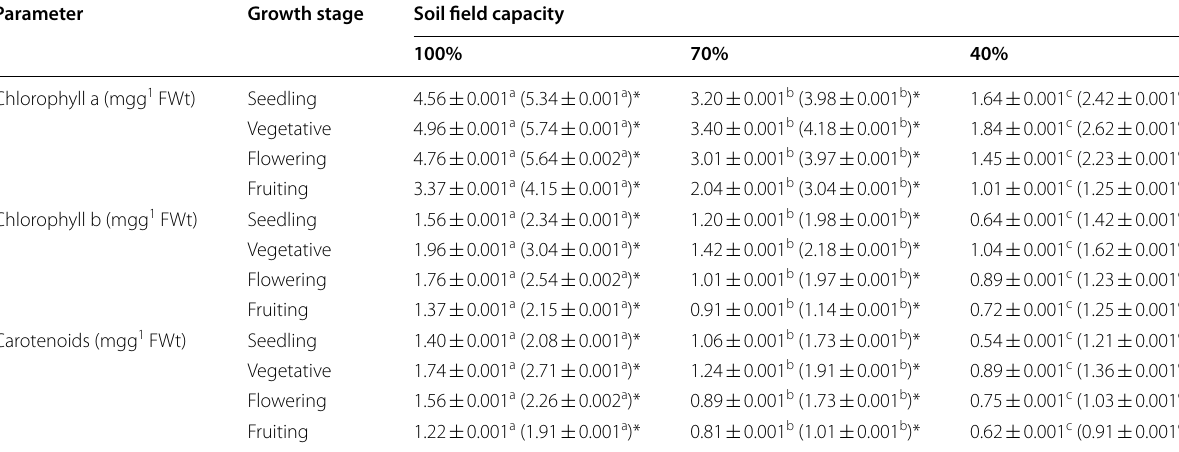
Values of parameters in parentheses correspond to the application of mycorrhiza. Values in a row with different superscript letters are significantly different at P < 0.05 * Significant effect of mycorrhiza application at each soil field capacity at P < 0.05 according to t ‑test ns : non‑significant effect of mycorrhiza application at each soil field capacity at P < 0.05 according to t-